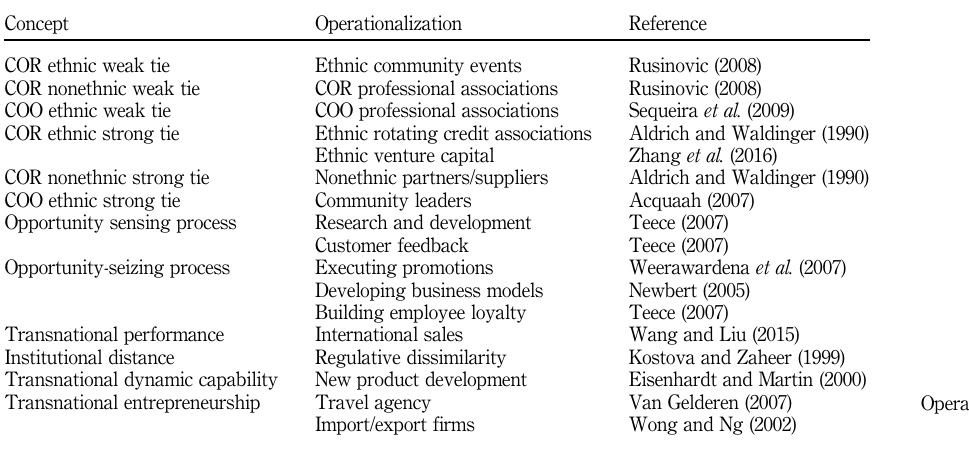
Table I. Operationalization of